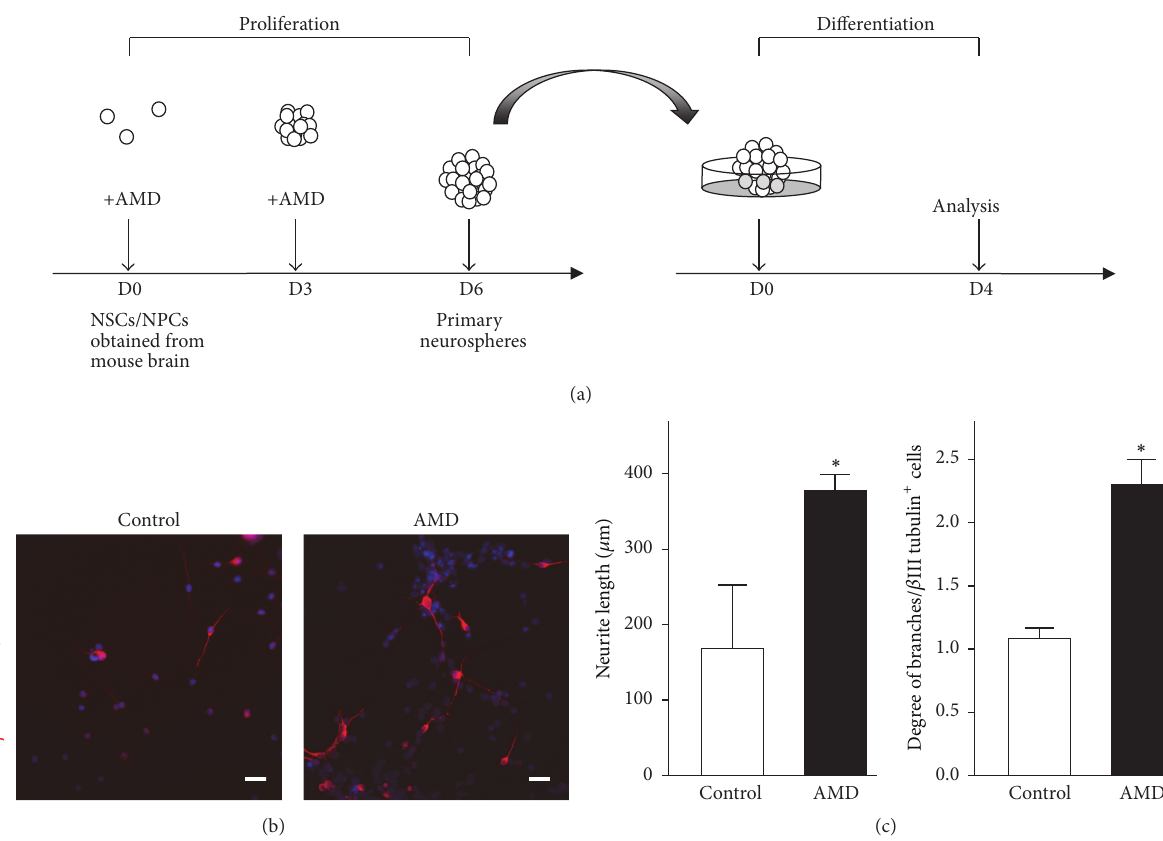
Figure 7: Blocking of CXCR4 transduction facilitated the neurites outgrowth and branching in differentiated neurons. (a) Schematic representation of the protocol used in this study. (b) Representative images of 𝛽 III tubulin + (red) cells cultured from mouse brain-derived neurospheres after 6DIV PBS or AMD treatment. The neurospheres were reseeded onto a poly-D-lysine-coated dish and allowed to differentiate for 4 days. Scale bar, 25 𝜇 m. (c) Average neurite length (left panel) and branching degree (right panel) of 𝛽 III tubulin + cells, where the AMD-treated group showed significant increase in both length and branching level. Data represent the mean ± SEM, control, 𝑛 = 3 ; AMD, 𝑛 = 4 , ∗ 𝑝 < 0.05 , Student’s 𝑡